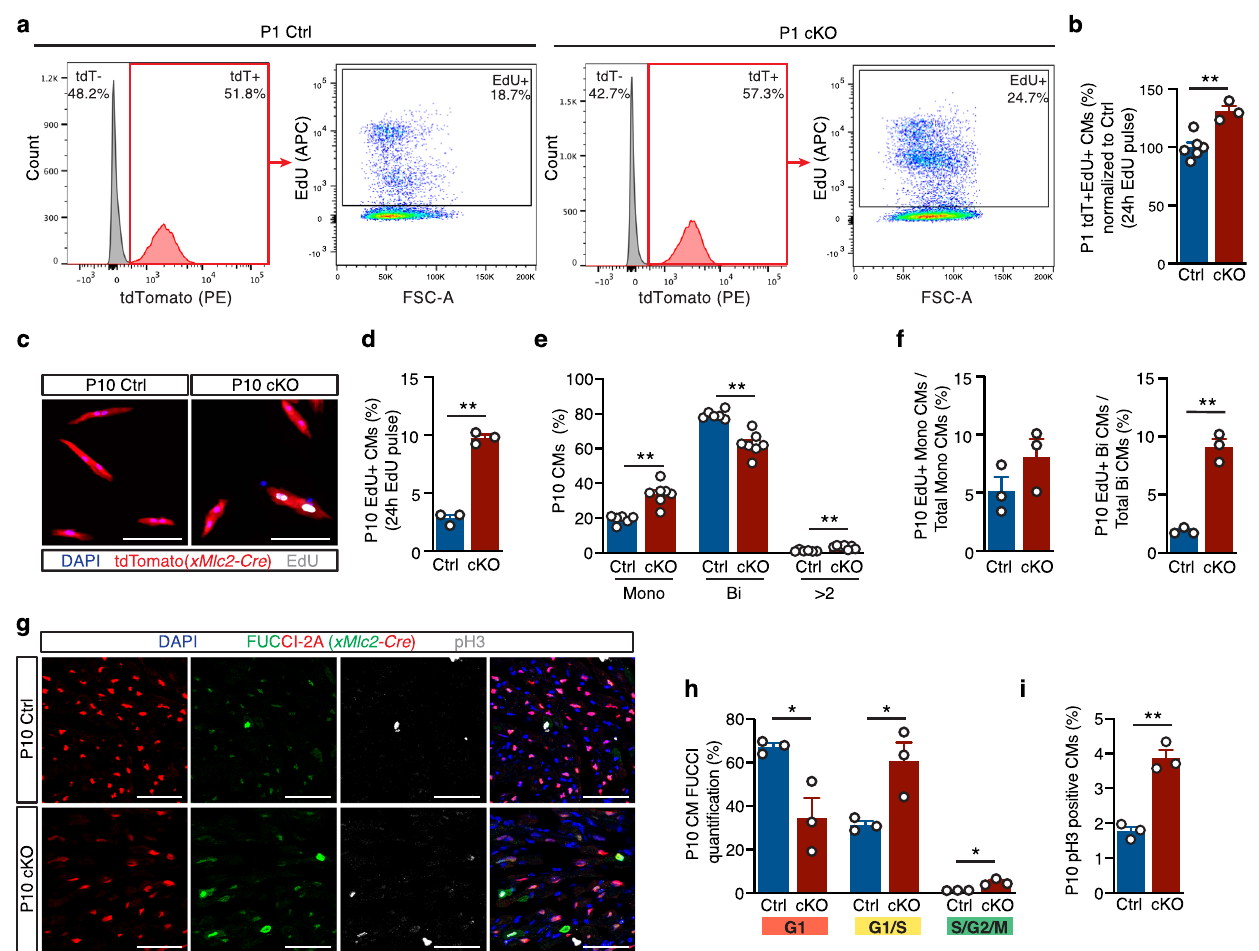
Fig. 6 | Neonatal Dot1L cKO cardiomyocytes fail to undergo cell cycle with- drawal. RepresentativeFACSanalysis( a )andrespectivequanti fi cation( b )showing signi fi cantlyincreasedEdUincorporationwithinP1CMs(tdTomato+cells)ofDot1L cKO vs Ctrl hearts (Ctrl N =6, cKO N =3 biological replicates, unpaired t -test, two- sided, P =0.0025). Representative immuno fl uorescenceimages ( c ),and respective quanti fi cation (d )showingsigni fi cantlyincreasedratesofEdUincorporationinP10 CMs isolated from Dot1L cKO vs Ctrl hearts. DAPI in blue, endogenous tdTomato signal driven by xMlc2 -Cre;Rosa26-tdTomato in red and EdU in white. (Scale bar= 100 μ m; Mean of 755 CMs counted per heart from N =3 biological replicates, unpaired t -test, two-sided, P <0.0001). e Quanti fi cation of relative percentage of mononuleated (Mono), binuclated (Bi) or multinucleated (>2) CMs in P10 Dot1L CtrlsandcKOs.AtP10,Dot1LcKOheartshadmoremononucleated(Mono)andless binucleated (Bi) CMs than littermate Ctrls (mean of 697 CMs counted per heart from N =6Ctrland N =7cKObiologicalreplicates,unpaired t -test,two-sided,Mono P =0.0002, Bi P <0.0001, >2 P =0.0007). f Quanti fi cation of percentage of EdU+